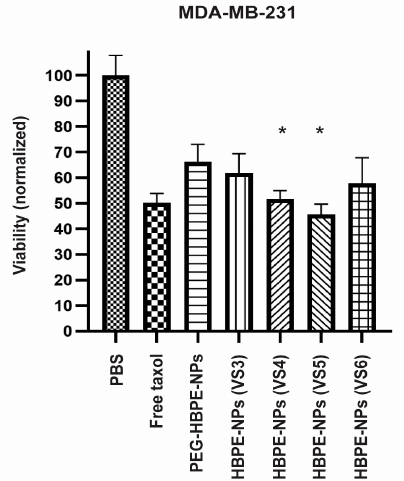
Figure 3. Increased Taxol-mediated toxicity of breast cancer cells when the drug is delivered using HBPE-NPs coated with sera collected from IAV-infected mice. MTT viability assay was carried out to evaluate the toxicity of Taxol-loaded HBPE-NPs. MDA-MB-231 cells were treated with PBS vehi- cle, free Taxol, PEG-HBPE-NPs, HBPE-NPs (VS3), HBPE-NPs (VS4), HBPE-NPs (VS5), or HBPE- NPs (VS6). Data represent mean ± standard deviation (n = 3). * p -value < 0.05 relative to PEG-HBPE-